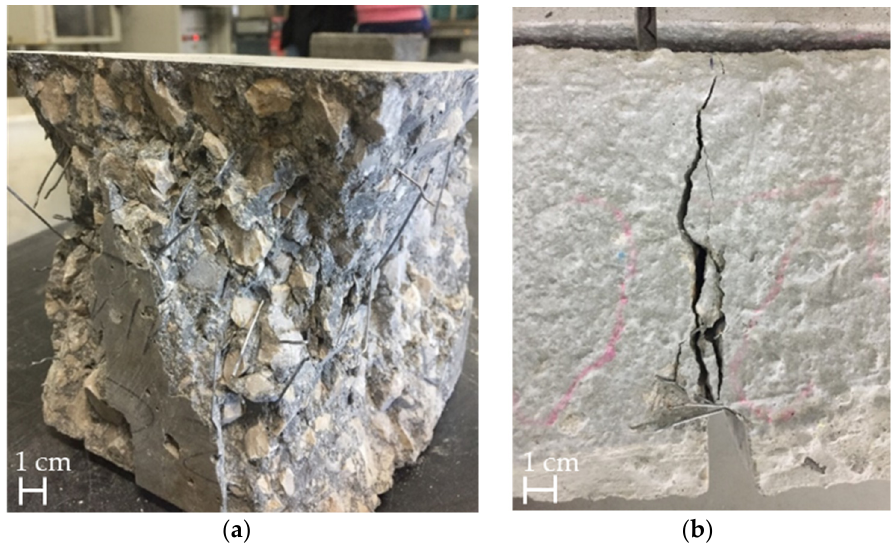
Figure 9. Specimens after compressive test ( a ) and flexural test ( b ).